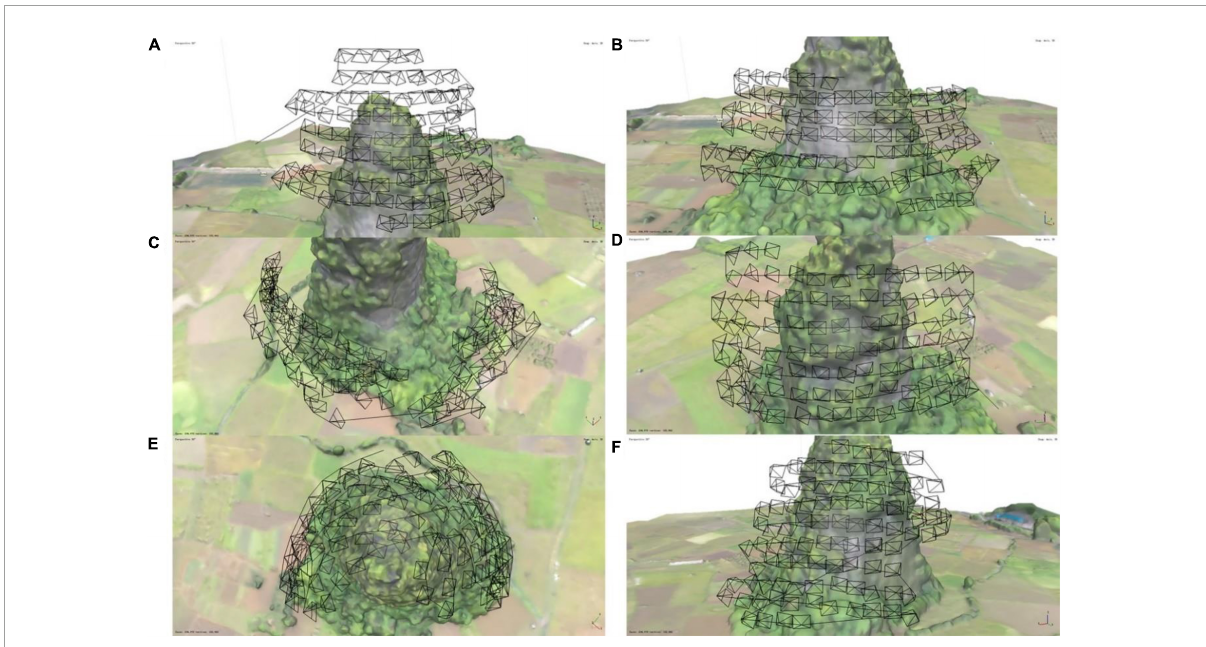
FIGURE4 The survey route of the surrounding photography, showing 99 photograph points per flight route. (A) The first route, located at the top of the cliff. The first waypoint of (B) continues after the last waypoint of (A) , and so on. The last point of (C–F) completed photo capture, after which the drone returned automatically.